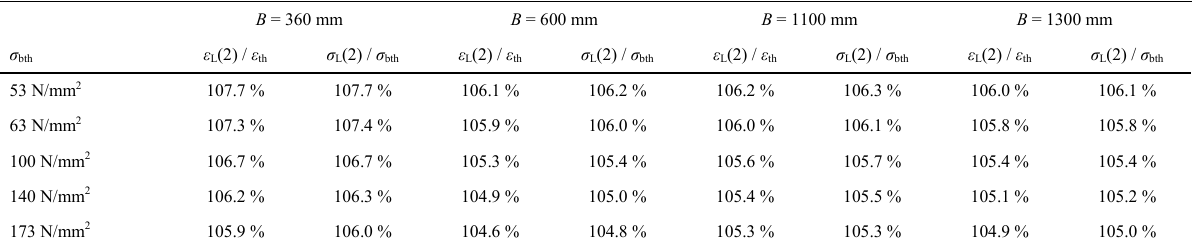
Table 1: Development of the relative peak strains and stresses at the edges (2) with increasing specimen width B at different loads. B = 360 mm σ bth